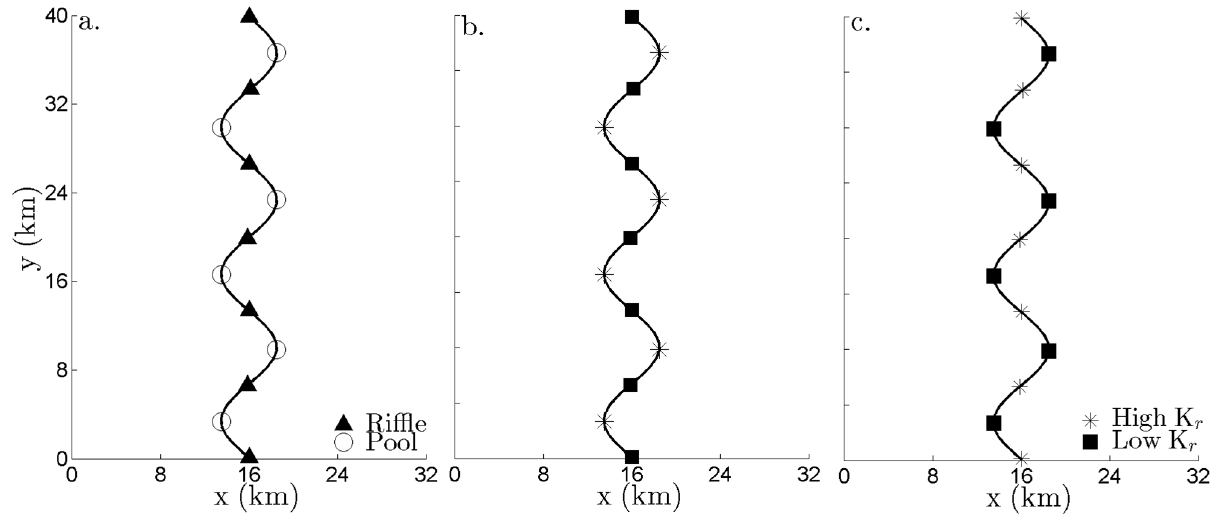
Plan view of the modeled aquifer, showing ( a ) the assumed pool and riffle sequence; ( b ) the streambed K pattern under high flow regime conditions; and ( c ) the r streambed K pattern under low flow regime r